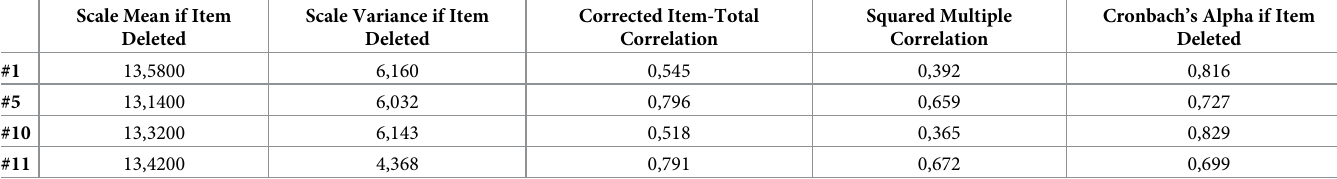
Table 17. Item-total statistics for subscale 3 (DLGs).